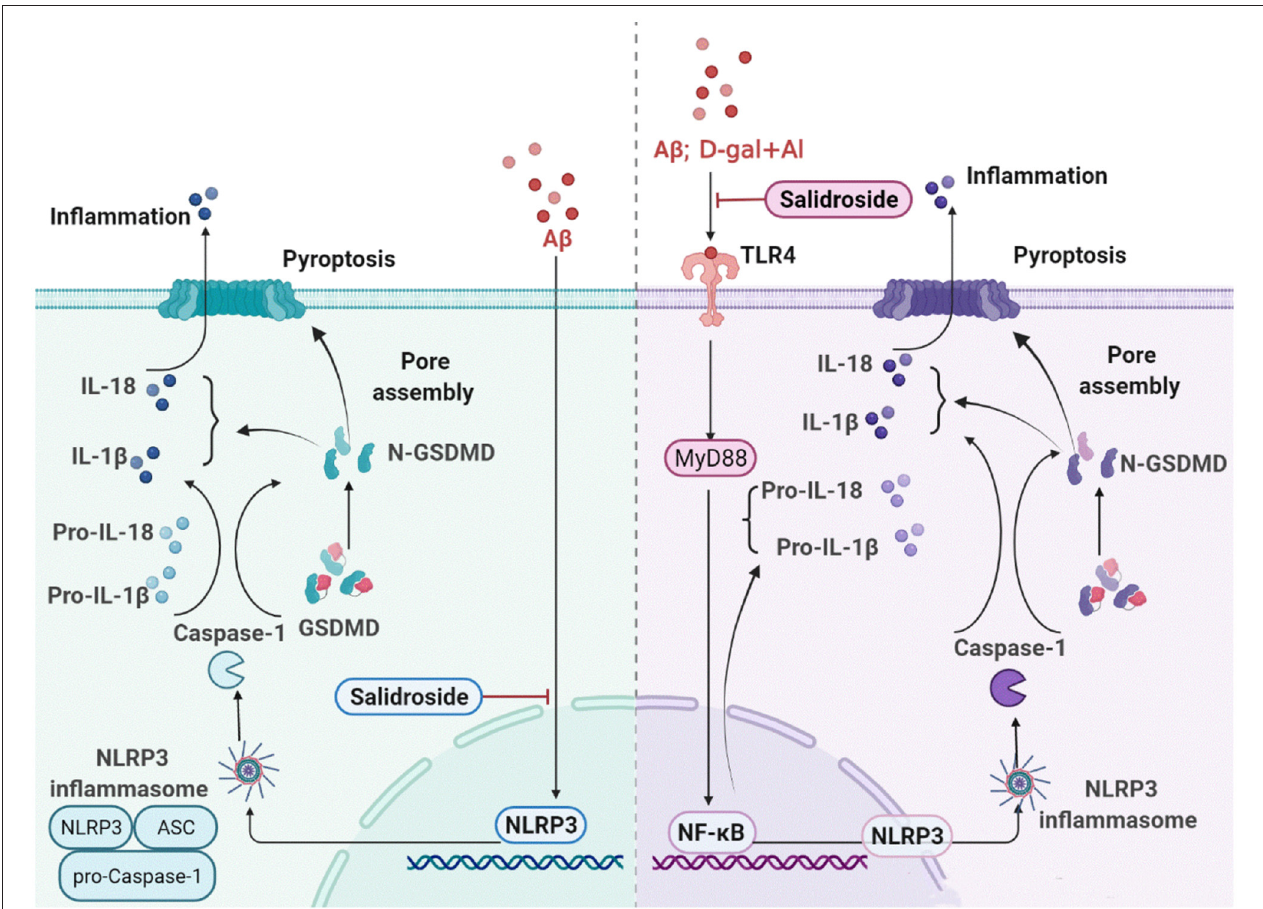
FIGURE 11 | Sal ameliorates AD by suppressing NLRP3-mediated pyroptosis. The primary mechanism is described below: (1) Sal directly reducing the accumulation of A β , thus inhibited pyroptosis by blocking the NLRP3 inflammasome activation, mainly through inhibiting NLRP3/caspase-1 signaling pathways; (2) Sal indirectly suppressed pyroptosis through inhibiting TLR4, the mechanism may via TLR4/NF- κ B/NLRP3 signaling pathways. These results exhibited that inhibiting pyroptosis through treatment by Sal could be a new approach in the therapeutic treatment of AD.